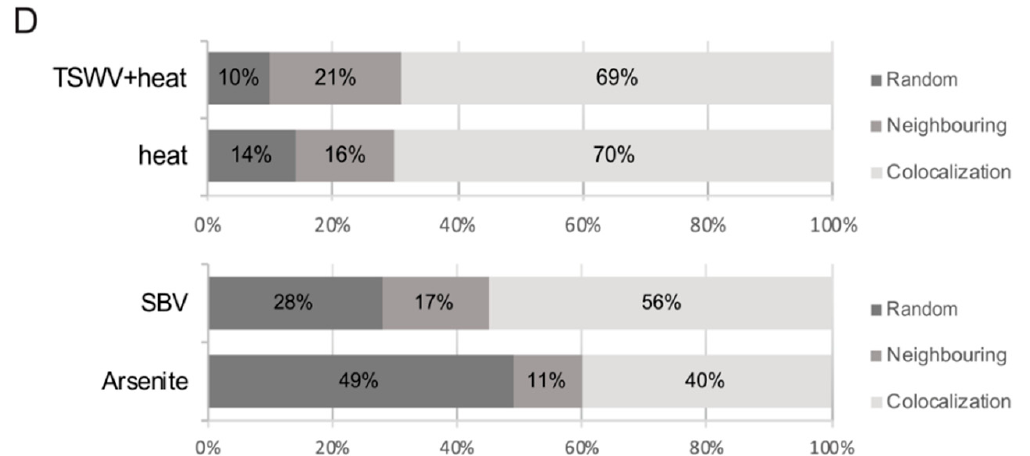
Figure 3. Localization and quantification of N proteins relative to individual PB and SG marker proteins, and PB-SG docking stages. ( A ) Images of TSWV N protein expression in Vero cells, subjected to arsenite treatment for SG-induction, showing the spatial distribution of N protein relative to PB and SG markers (Upper panel). Images of TSWV N protein expression in N. benthamiana cells, subjected to a heat shock for SG-induction, showing the spatial distribution of N protein relative to PB and SG markers (lower panel). ( B ) Graphical description of different patterns of N protein associated with SG in different connections to PB (Left panel). The indication “I” represents individual SG distant from PB, “C” represents SG close to PB. “D” represents SG docked on PB. ( C ) Quantification of transiently expressed TSWV and SBV N protein associated with different types of SG, as defined in panel B, in Vero cells, and of TSWV N protein in plant cells. ( D ) Quantification of PB and SG association types in plant cells after TSWV infection + heat shock and after heat shock only (upper half of the panel) and quantification of PB and SG association types in animal cells after SBV infection and after arsenite treatment (lower half of the panel).